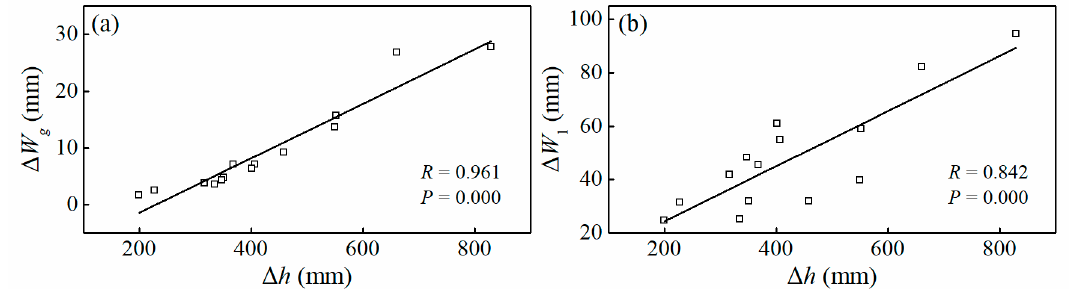
Figure 8. The correlation between ( a ) ground water utilization ( Δ W g ) and ( b ) soil ‐ ground water storage utilization below 1 m soil depth ( Δ W 1 ) with the increase of the water table depth during the crop growing season ( Δ h ) in Jiefangzha.